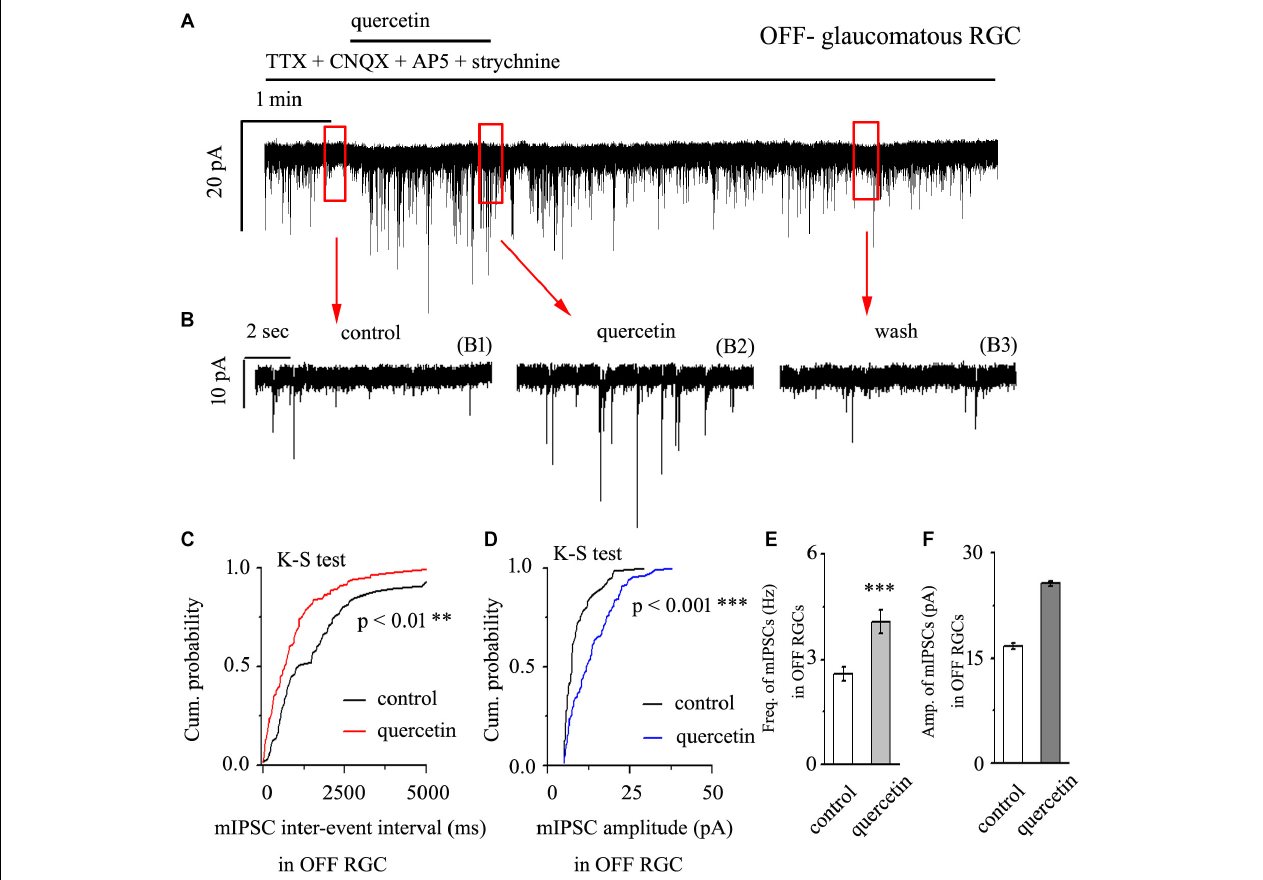
FIGURE 4 | Quercetin increased the frequency and amplitude of GABAergic mIPSCs in OFF-type RGCs. (A) Representative traces showing the effect of 10 µ M quercetin on mIPSCs. Vertical scale bar, 20 pA; horizontal scale bar, 1 min. (B) Recordings from a large-scale representative experiment under control conditions (B1), during quercetin treatment (B2), and during recovery (B3). (C,D) Cumulative frequency and amplitude distributions of GABAergic mIPSCs in a representative neuron under control conditions and during quercetin treatment showing that quercetin caused the cumulative frequency curve to shift significantly to the left and the cumulative amplitude curve to shift significantly to the right. (E,F) Summarized data on the frequency (E) and amplitude (F) of GABAergic mIPSCs ( n = 9; from six slices). ∗∗ p < 0.01 and ∗∗∗ p < 0.001 compared with the control conditions; paired Student’s t -test.